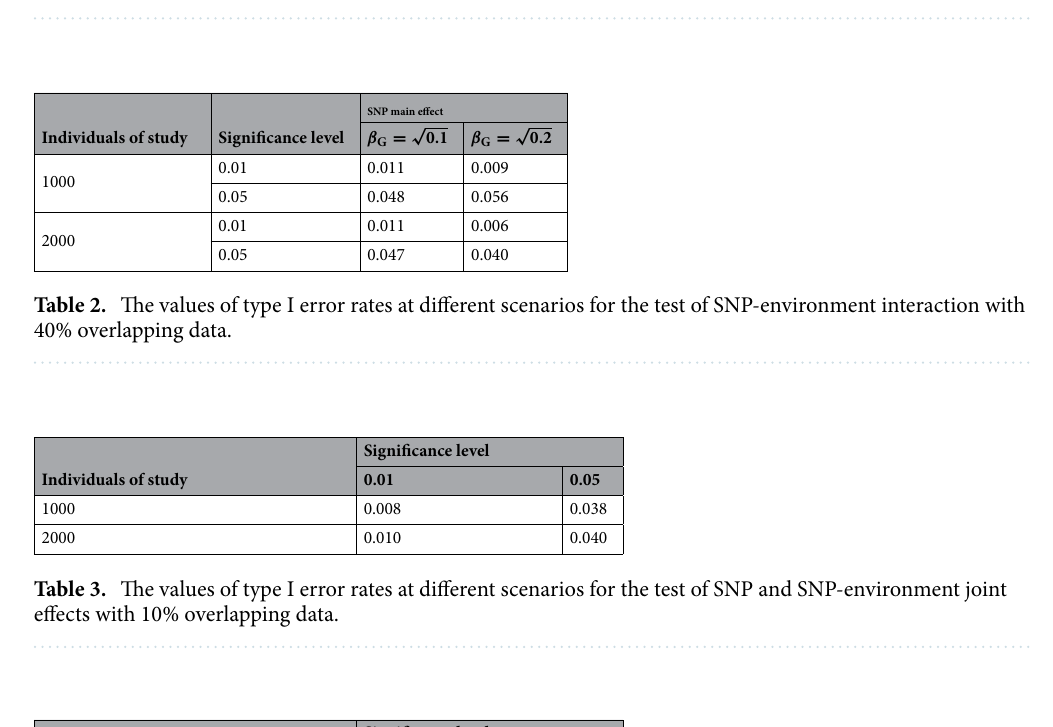
Table 1. The values of type I error rates at different scenarios for the test of SNP-environment interaction with 10% overlapping data.